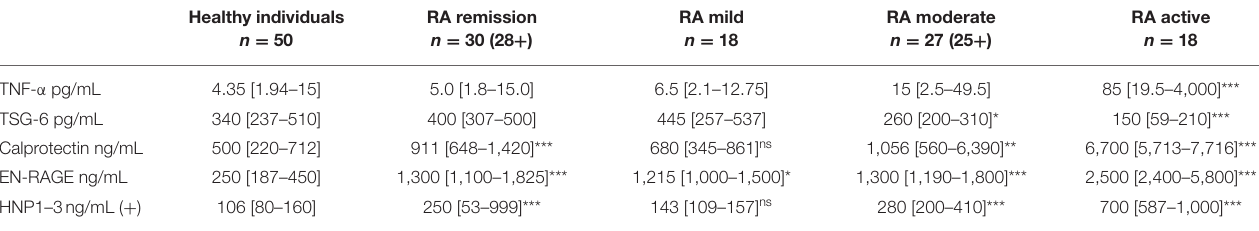
TABLE 2 | Levels of inflammatory mediators in the plasma of RA patients and in healthy donors. Healthy individuals n =